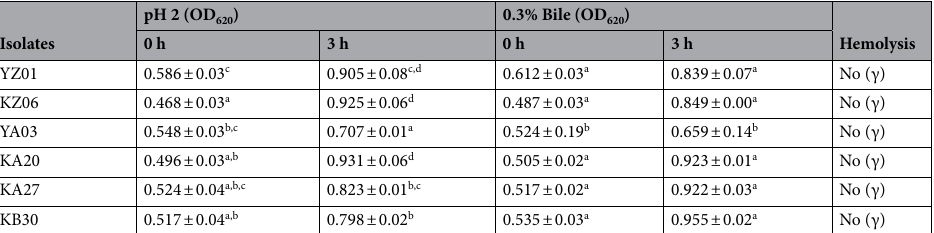
Table 2. Growth of selected lactic acid bacteria in pH 2, 0.3% bile salt and their hemolytic property. Data represent the mean value of triplicate optical density (OD) taken at 620 nm and expressed as mean ± standard deviation. Values on the same column followed by the same alphabetical superscript are not significantly different from each other at p < 0.05 using one way analysis of variance (ANOVA) and Duncan’s multiple range test. Gamma (γ ) hemolysis represents no hemolysis. NB: Tolerance of Isolates LBH1066, 1073, 1074 to pH and Bile 44 , LBH1148 (Data not available). Hemolytic property of isolate LBH1066, 1073, 1074, 1148 (Data not available).